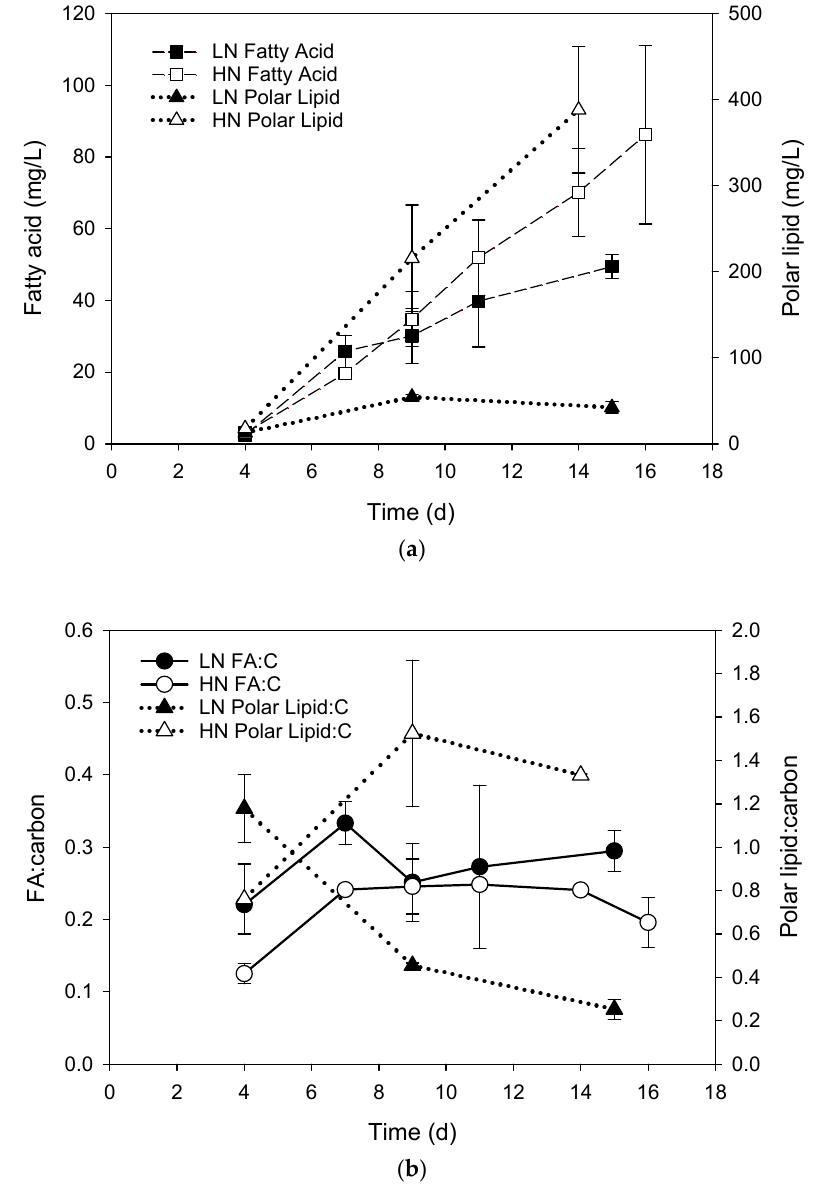
Figure 2. ( a ) Volumetric fatty acid and polar lipid concentrations and ( b ) fatty acid and polar lipid/carbon ratios (mg:mg) in Chlorella sp. grown in batch cultures containing LN or HN media (legends inset).